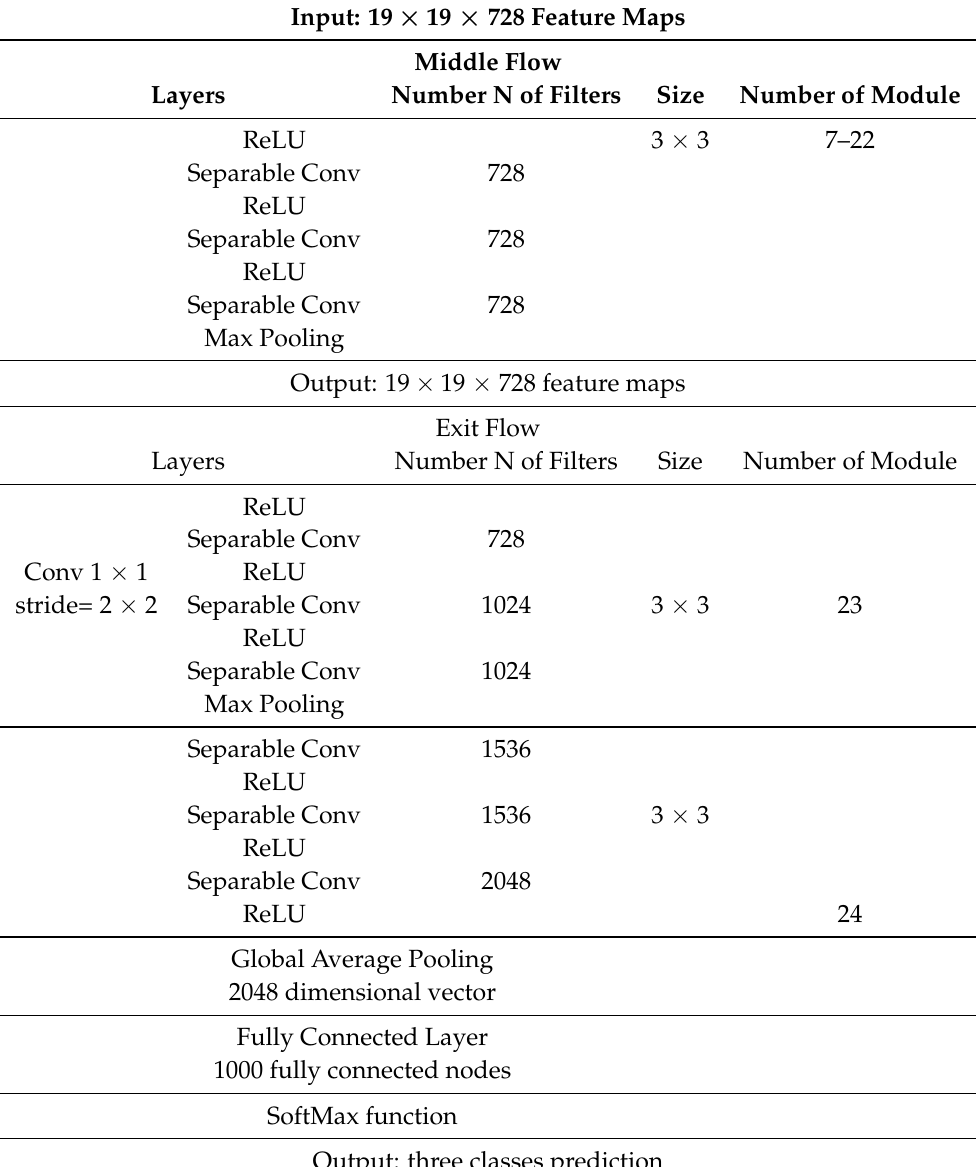
Table 3. Structure of the Middle and Exit Flow of the CNN model. All separable convolutional filters have a size of 3 × 3. All maxpool layers use the size F =